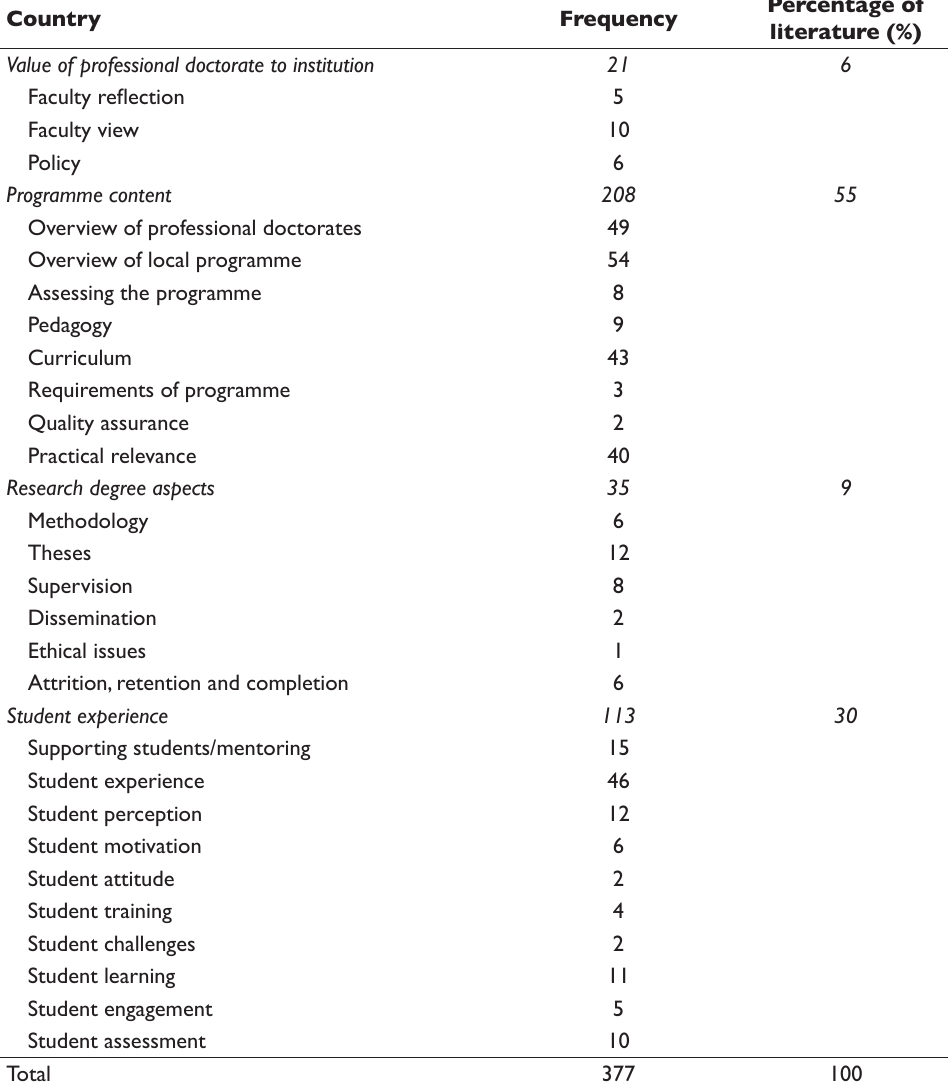
Table 3: Distribution of the literature by theme